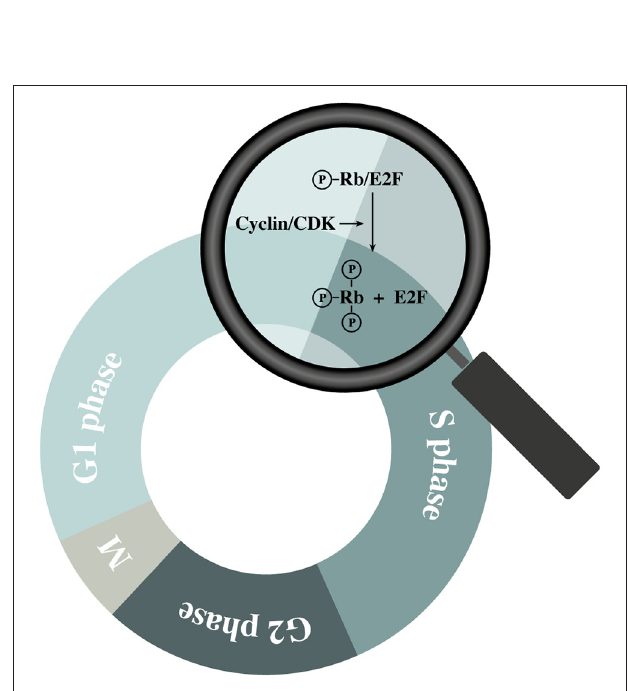
FIGURE 2 | Schematic representation of retinoblastoma (Rb) protein hyperphosphorylation during the G1 phase.